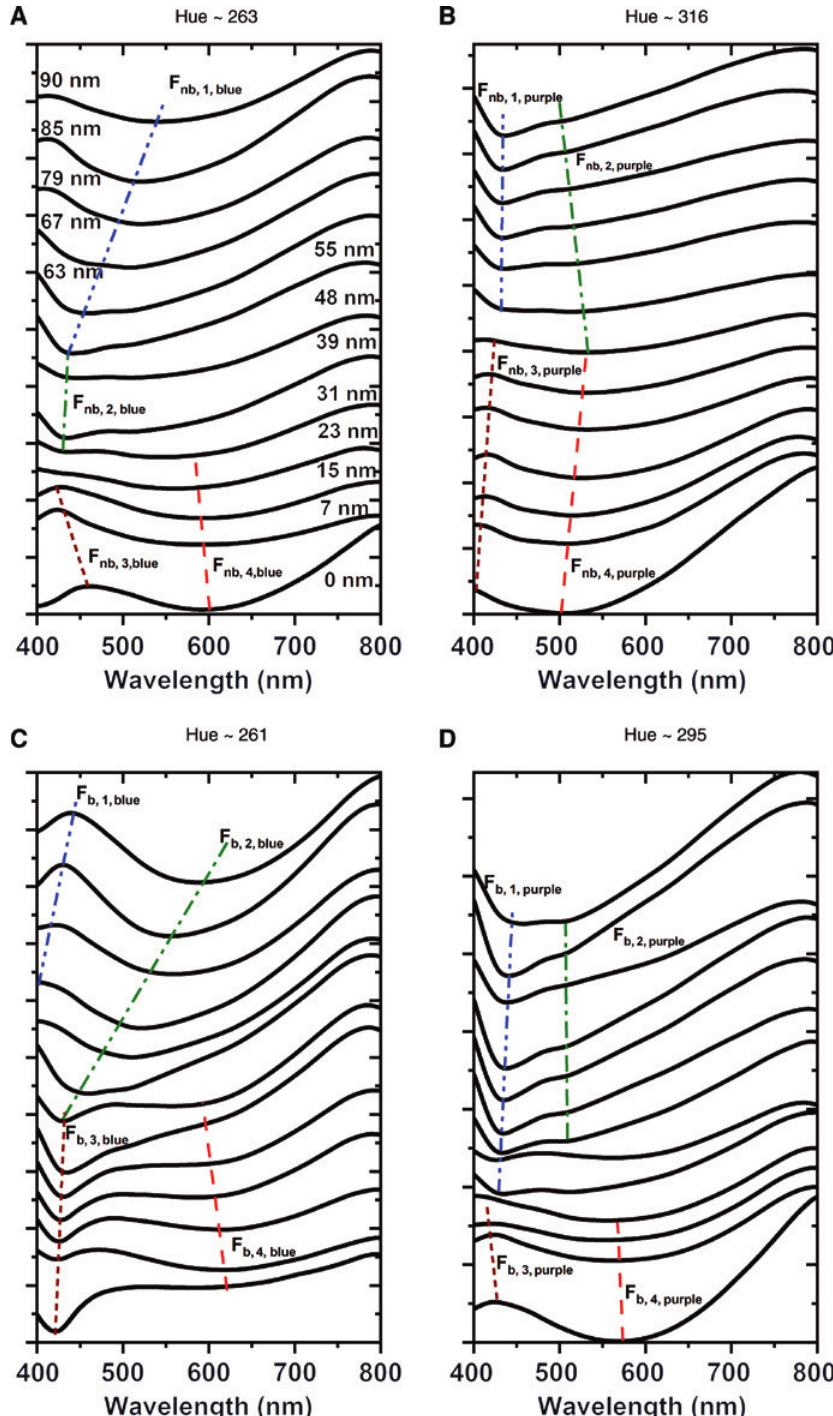
Figure 5: Experimental reflectance spectra. Measured reflectance spectra using unpolarised light with increasing alumina thickness for blue (left) and purple (right) colours written using (A, B) the nonburst method (laser fluence of 5.73 J/cm 2 , marking speed of 100 mm/s), and (C, D) the burst method (laser fluence of 12.12 J/cm 2 , marking speed of 150 mm/s). The blue colours were written using a line spacing of 5 μ m and the purple colours were written using a line spacing of 8 μ m. The shifting of spectral features with increasing alumina thickness is tracked with straight lines of different line styles (as a guide to the eye). The original hue values are identified at the top of each